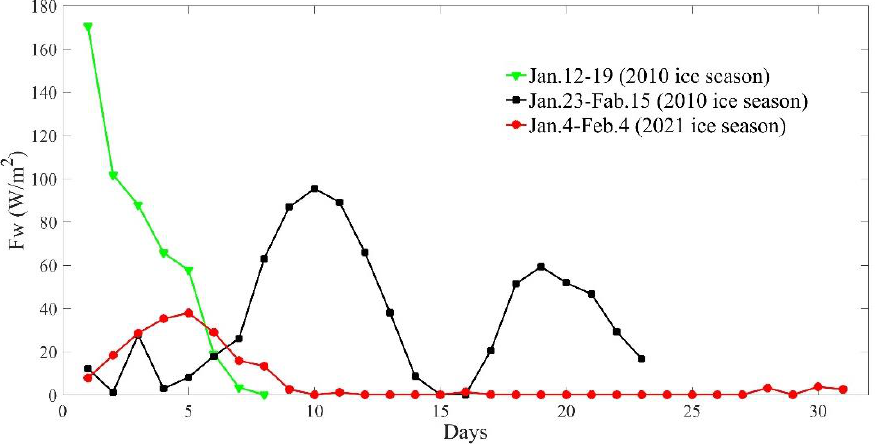
Figure 9. Time series of oceanic heat flux ( 𝐹 𝑤